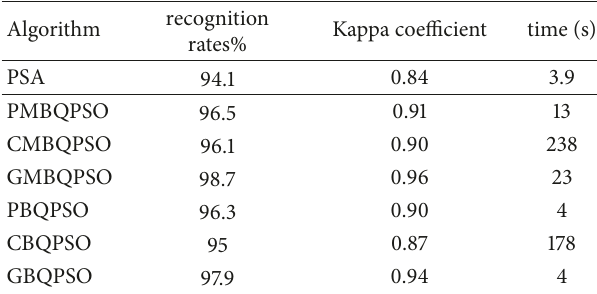
Table 3: Comparison of subpixel mapping results for Figure 4(b) with six kinds of